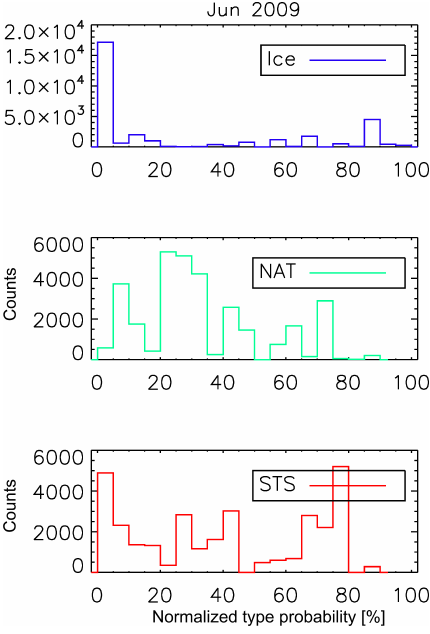
Figure 9. Event counts of the normalized probabilities P j for ice, NAT and STS mix of the Bayesian classifier for SH June 2009 cloudy spectra above 12km altitude.